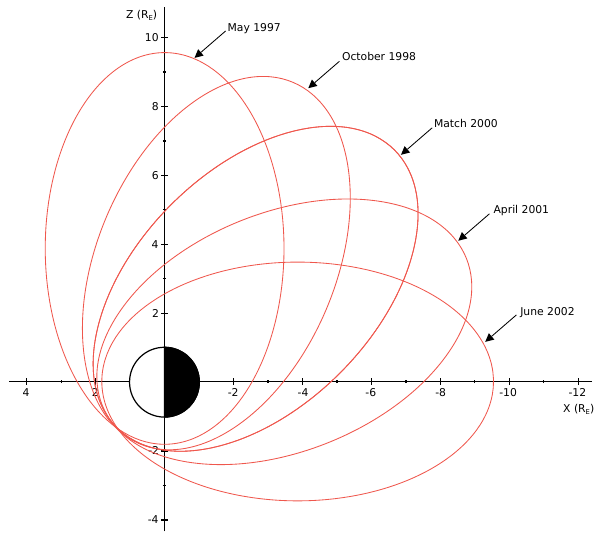
Fig. 1. The precession of the Polar orbit with apogee progressing from the North Pole to the Equator from 1997 to 2002. For purposes of comparison, the plane of the orbits were azimuthally rotated into the X–Z plane.